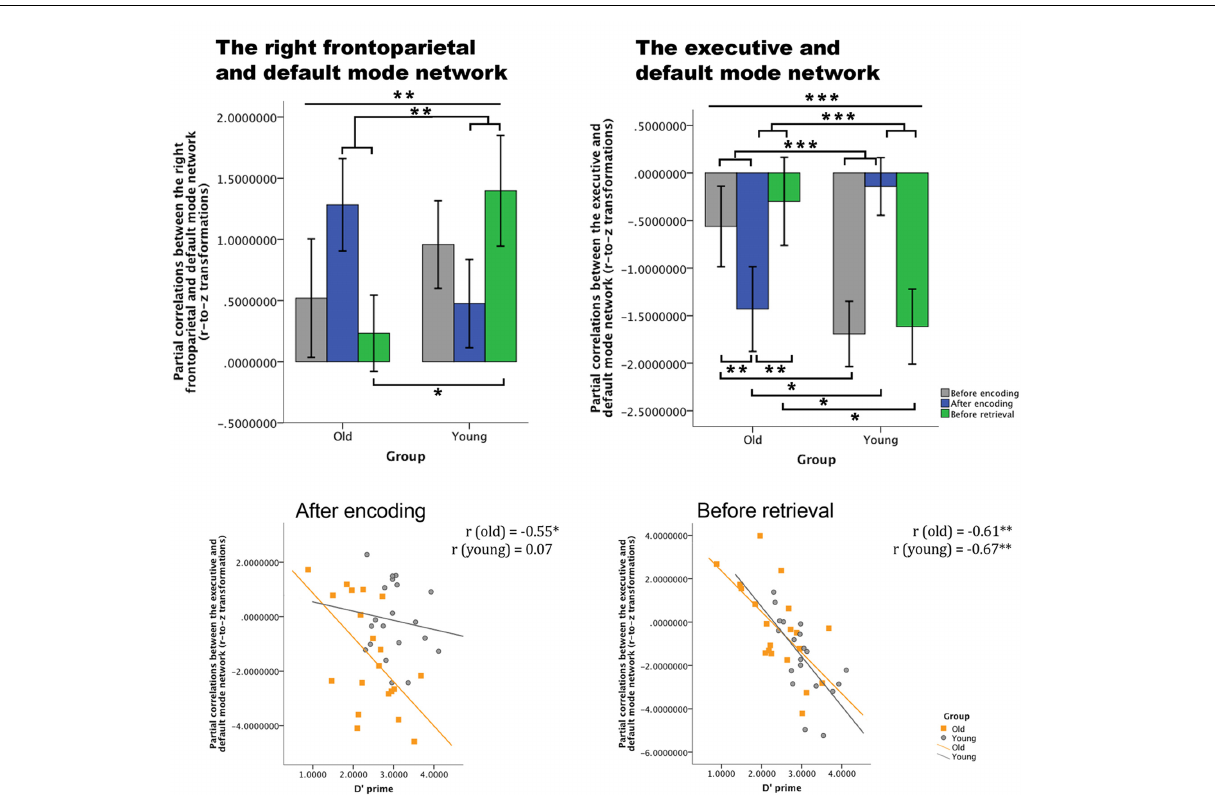
correlations values of the coupling between the default mode network and the executive network, and on the other hand the d (cid:4) prime parameter for both groups. There is a significant association for older adults after encoding and before retrieval, for younger participants only before retrieval. ∗ p < 0 . 05; ∗∗ p < 0 . 01; ∗∗∗ p < 0 .